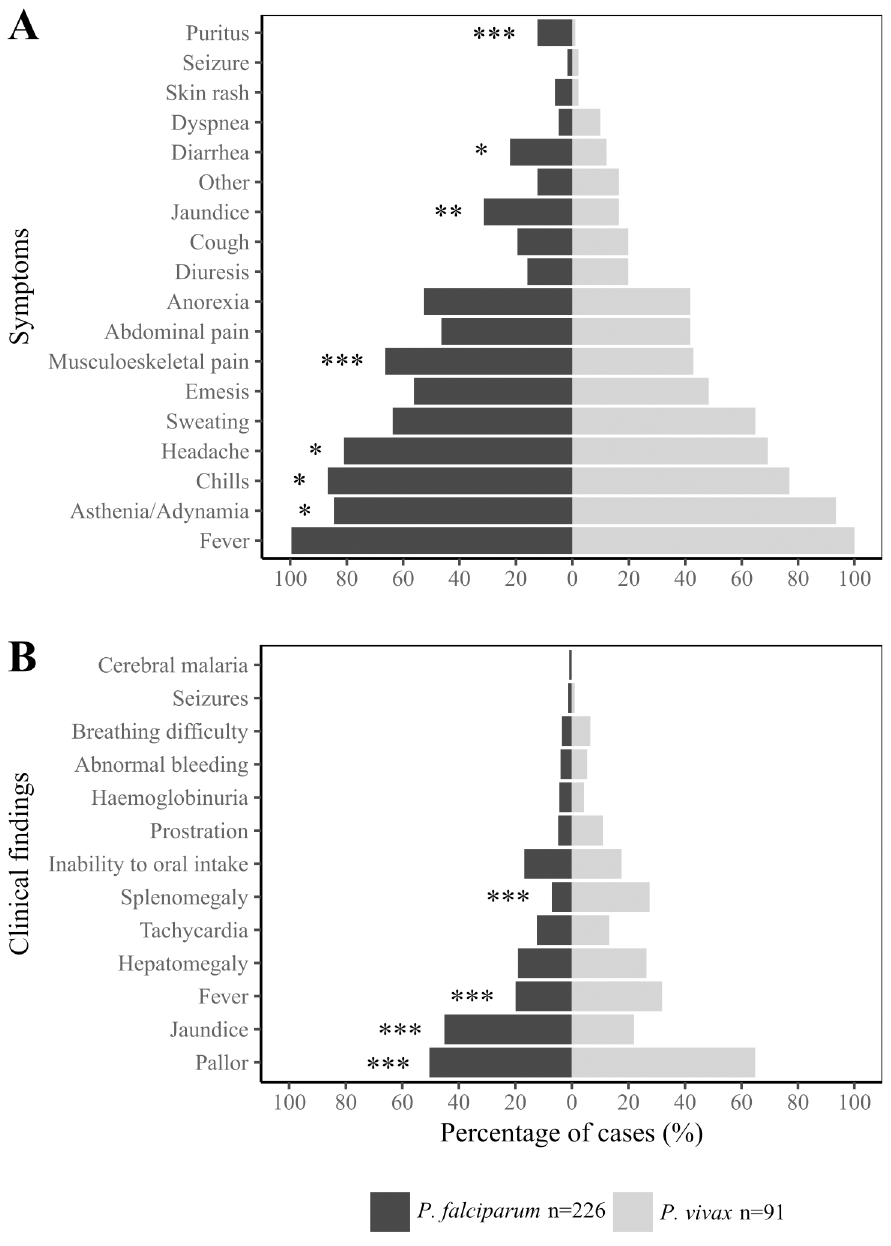
Fig 3. Frequency of clinical manifestations in P . falciparum and P . vivax infections. Percentages of malaria patients that reportedevery symptom (A) or presented with the listed clinicalfindings (B) are shown. All patients reportedmore than one symptom or had more than one sign. Statistical differences between species were calculatedusing the Chi-square test. * p value < 0.05, ** p value < 0.01, *** p value <